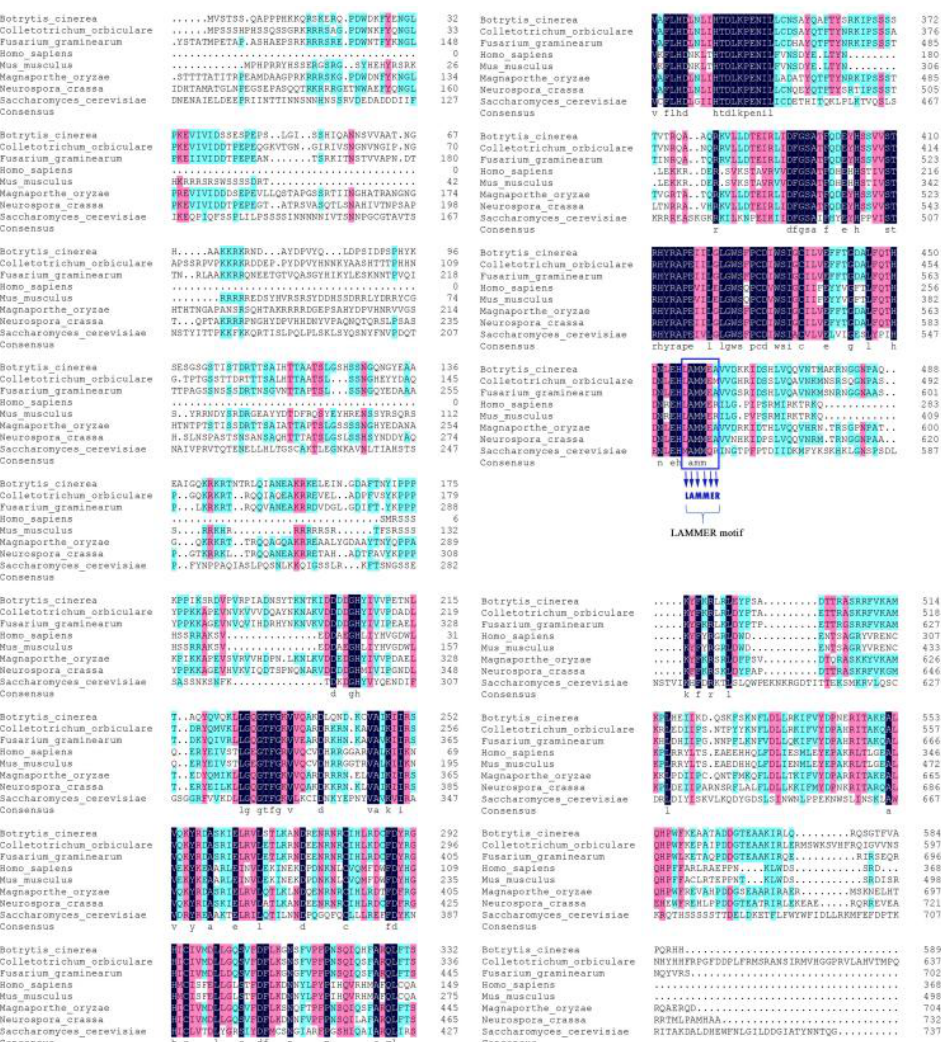
Figure 1. Sequence alignment of the amino acids of Kns1 in different species. A. The sequence alignment of Kns1 amino acids was made by the DNAMAN 8. The compared sequences were from Magnaporthe oryzae (MoKns1), Colletotrichum orbiculare (Lkh1, TDZ24089), Fusarium graminearum (Kns1, EYB28111.1), Homo sapiens (6FYK_A), Mus musculus (NP_001156904.1), Neurospora crassa (XP_957701.3), Saccharomyces cerevisiae (CAD6636070.1). All these Kns1 proteins have a conserved LAMMER motif (blue framed part).